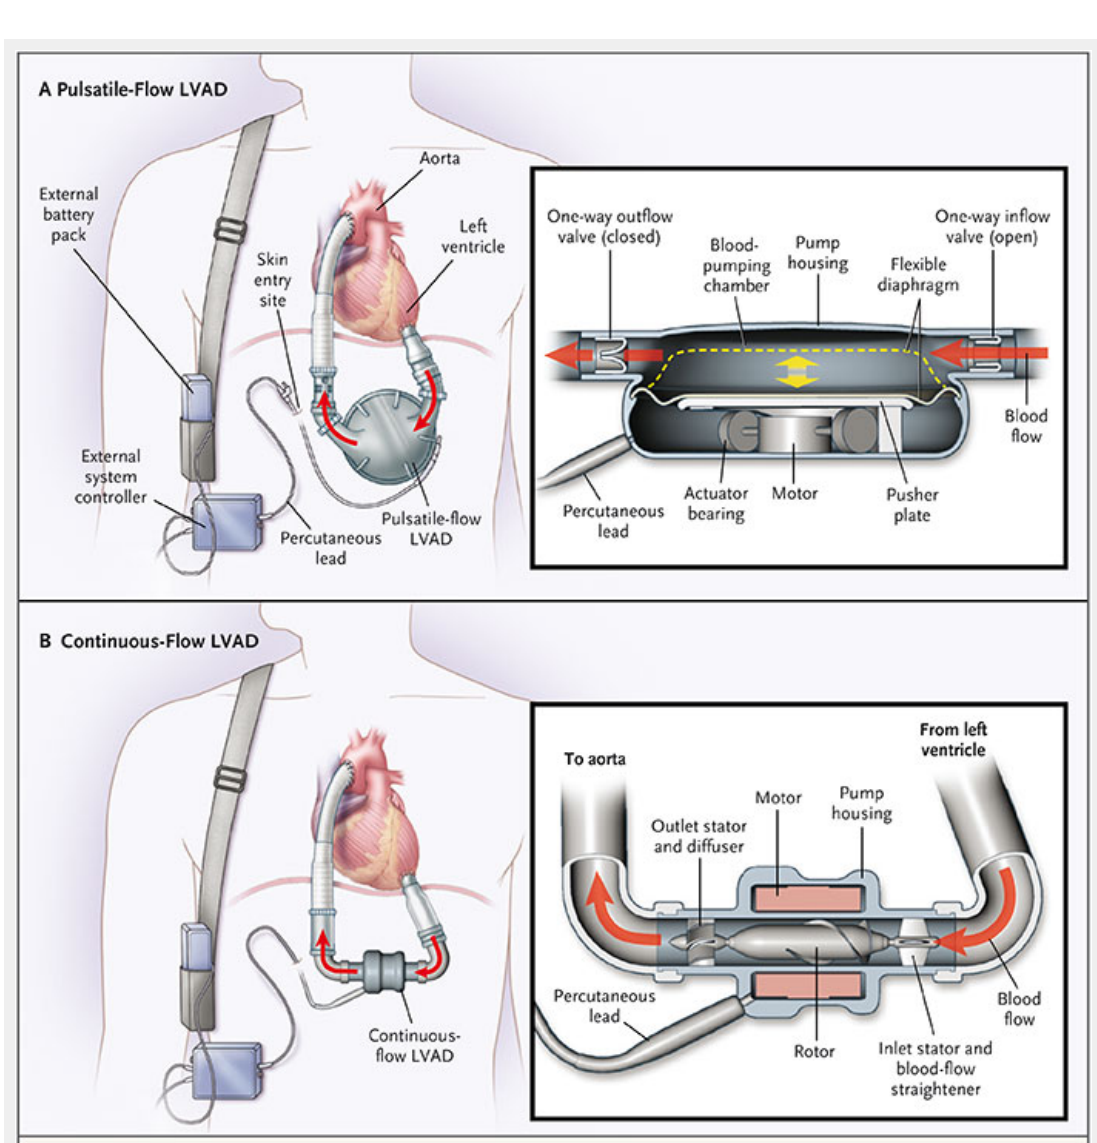
Figure 1 Pulsatile-flow (panel A) and continuous-flow (panel B) left ventricular assist devices (LVADs). © 2009 Massachusetts Medical Society. Slaughter MS, Rogers JG, Milano CA, Russell SD, Conte JV, Feldman D, et al. Advanced heart failure treated with continuous-flow left ventricular assist device. N Engl J Med 2009;361:2241-51 [11].Reprinted with kind